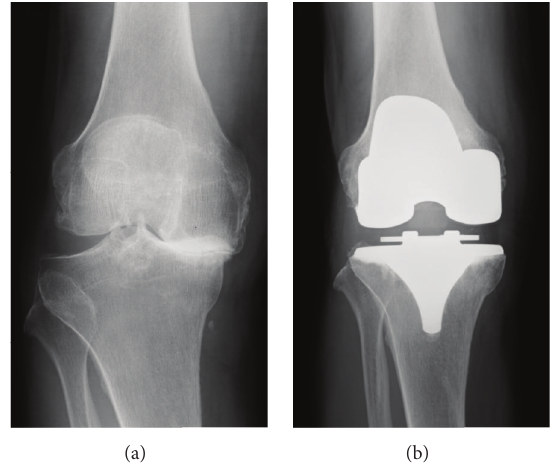
Figure 2: Preoperative (a) and postoperative (b) frontal radiographs of the